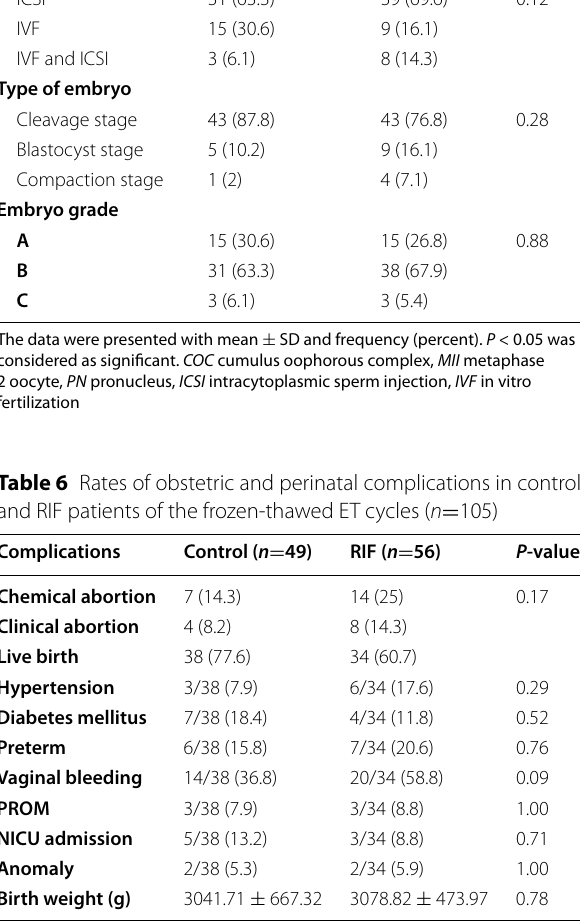
Table 5 Laboratory characteristic of the patients in the control 105) and RIF groups of the frozen-thawed ET cycles ( n =